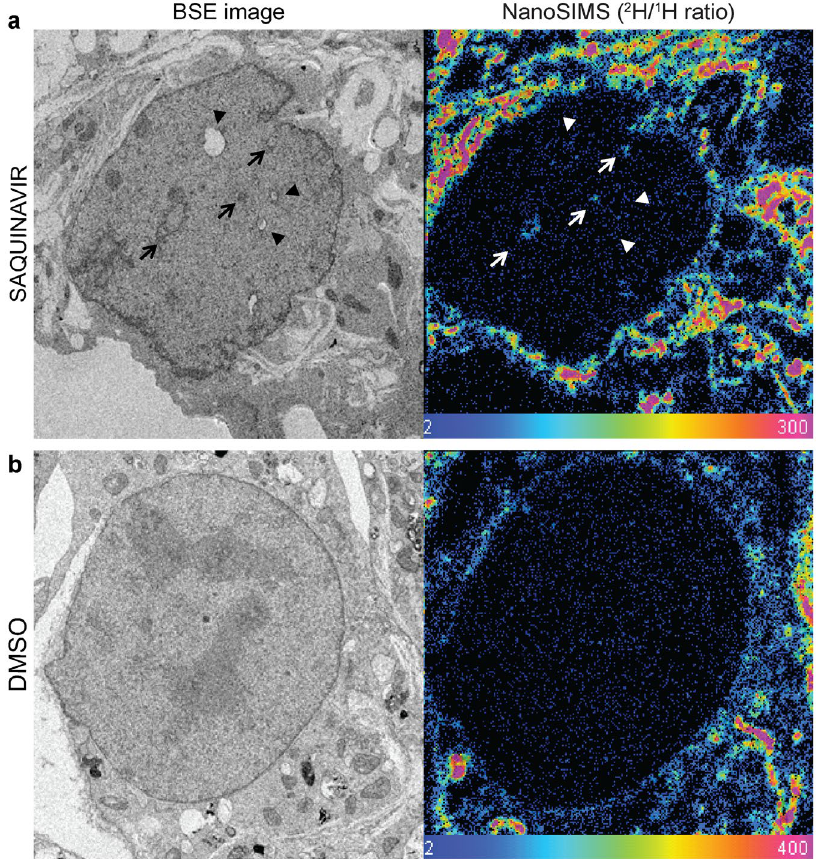
Figure 4. Detection of nascent phospholipids during NR formation by pulse labelling with deuterated stearate. ( a ) Representative backscattered electron (BSE) image of a saquinavir-treated mouse preadipocyte with black arrows indicating NR tubules with a corresponding image from NanoSIMS showing enrichment of deuterium signal ( 2 H/ 1 H ratio) indicating nascent fatty acyl species, also at the NR foci (indicated with white arrows); black arrowheads in BSE image correspond to NR presumably present in the nucleus prior to 2 H pulse, hence not showing enrichment in deuterium signal in the NanoSIMS image (white arroheads). ( b ) BSE and NanoSIMS images of a control cell treated with DMSO vehicle showing lack of NR tubules and no deuterium enrichment within the nucleus, and undistorted nuclear boundary. Colour scale of NanoSIMS images 2–400 equals 0.02–4% of 2 H/ 1